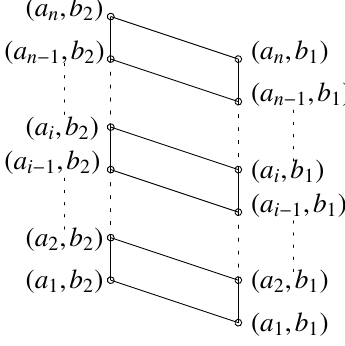
Figure 1: Hasse Diagram of L n × L